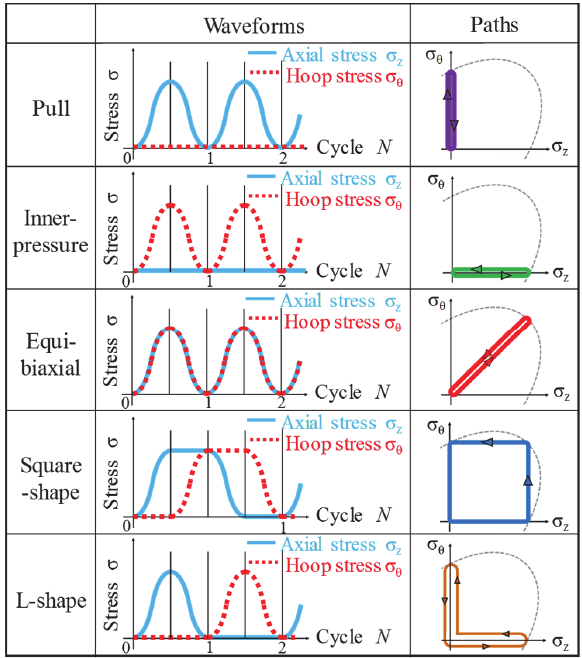
Figure 5: Loading waveforms and